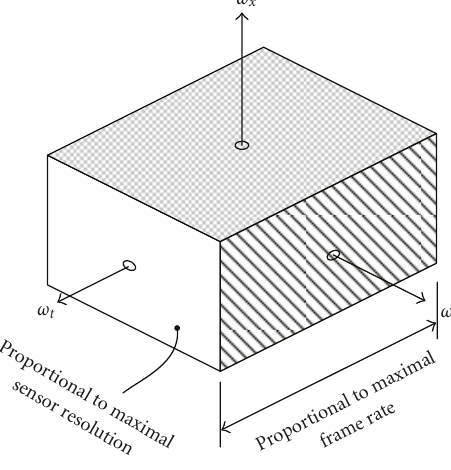
Figure 4: 3D spectrum of a typical video clip (shows only the ω t and ω x